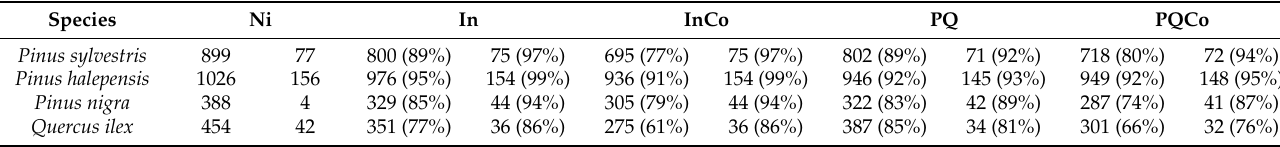
Table 1. Ni stands for both the number of individuals (white) alive in the three NFI and the number of plots (grey) used. We considered two aggregation levels (individual (In) and plot-quantile classes (PQ)) and two Equations (1) and (2) (Co for competition) for each of the four species ( Pinus sylvestris , Pinus halepensis , Pinus nigra , and Quercus ilex ) under study.